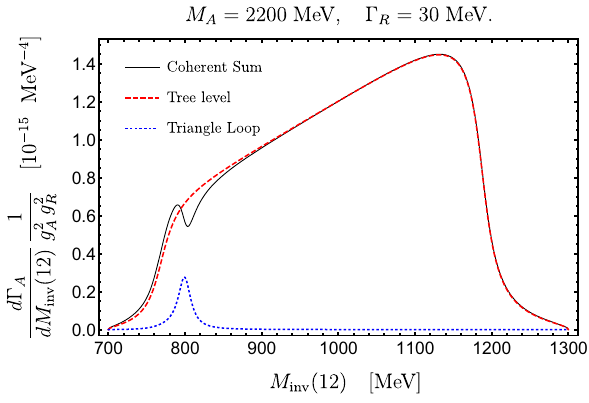
Fig. 7 Dalitz plot for A → 1 + 2 + 3 with the parameters of Eqs. (63) and (64). Point D corresponds to the triangle singularity